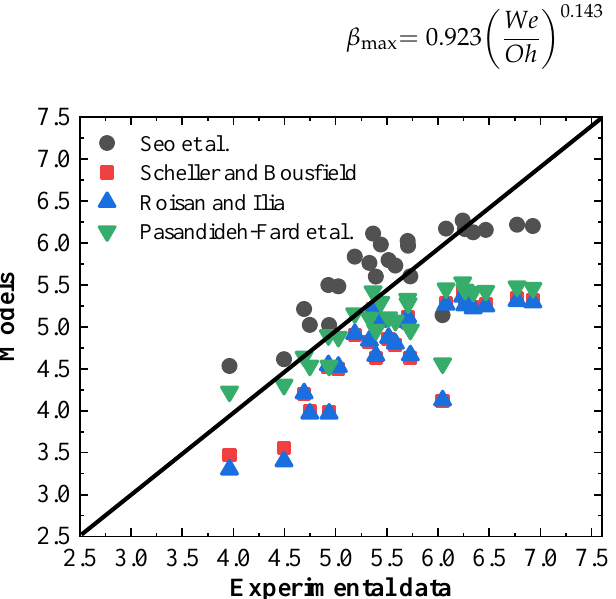
Figure 9. Comparison of experimental data with the predictive data by previous models. Table 2. Summary of models and their predictive mean